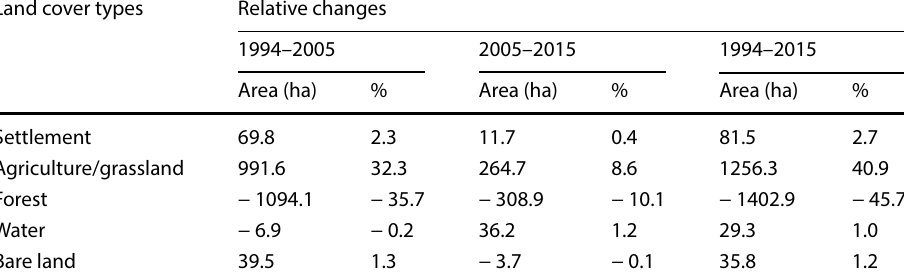
*Note: (−) sign indicates a decrease of change